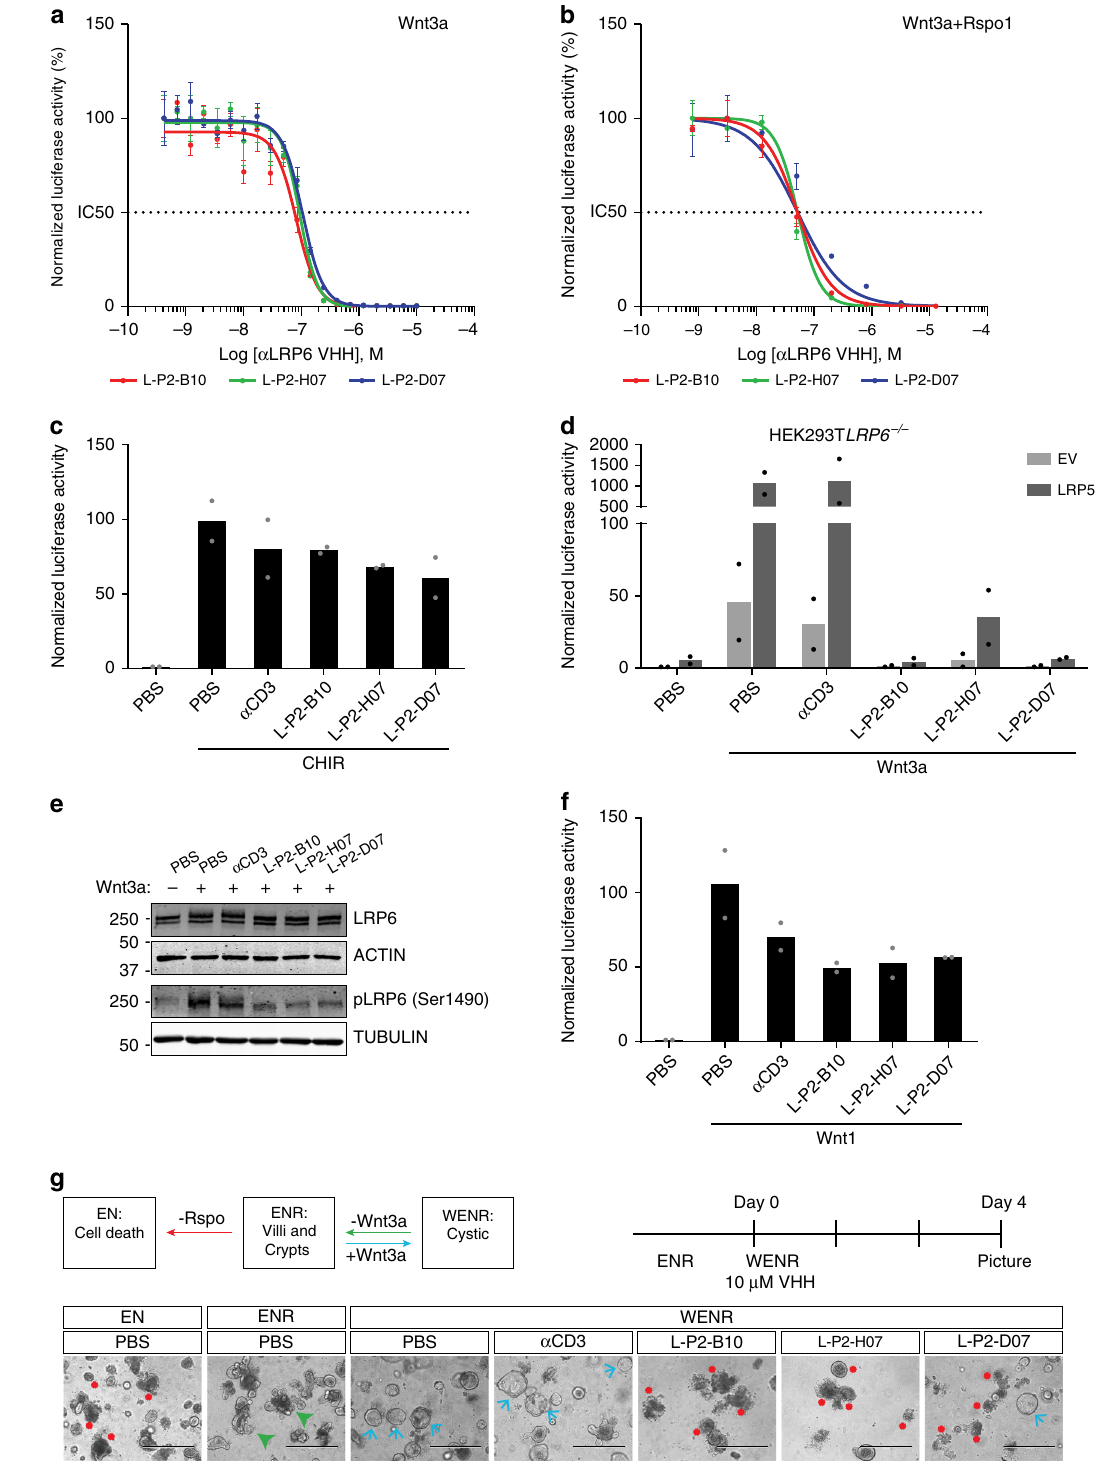
the proliferation marker Ki67 and the Paneth cell marker Lys, while the differentiation marker ChgA was increased upon VHH treatment (Fig. 5e). In conclusion, anti-LRP5/6 P3 VHHs effec- tively target Wnt-dependent tumorigenic organoids by removing an essential pathway for renewal of stem-like tumor cells and promoting their terminal